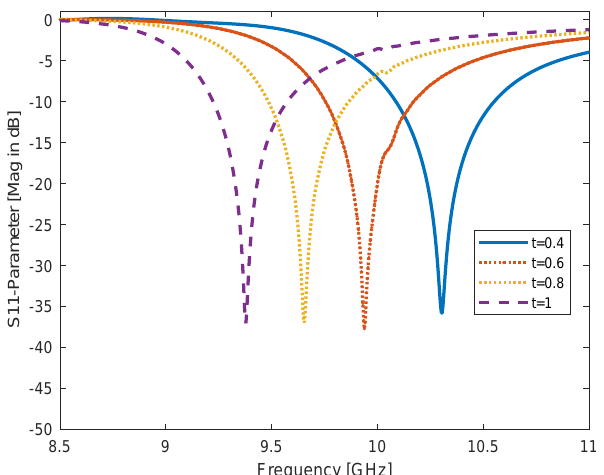
Figure 9. Alteration of CSRR height, h parameter for h = 0.3, 0.466, 0.633, and 0.8 mm, and the resonant frequency is shifted to the left.